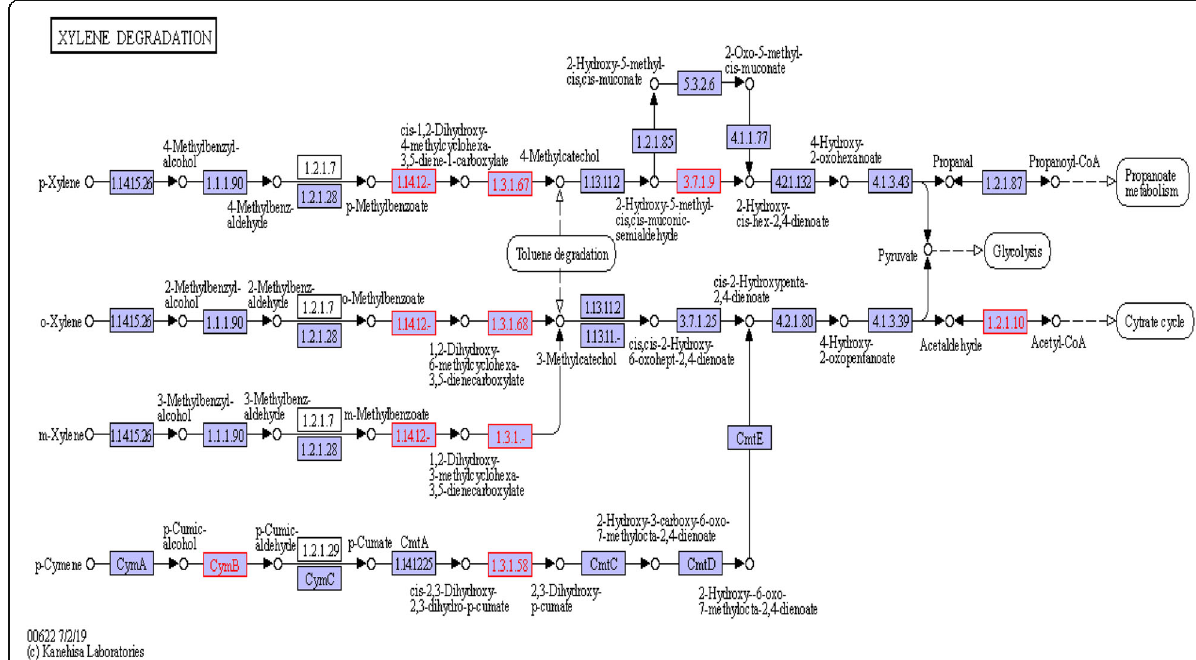
Fig. 5 The xylene degradation pathway performed using the KEGG pathway in KEGG Orthology. EC numbers in red are the xylene degradation genes identified in the FN1 microcosm. The identified genes are mhpF ; acetaldehyde dehydrogenase [EC:1.2.1.10], benD-xylL ; dihydroxycyclohexadiene carboxylate dehydrogenase [EC:1.3.1.25 1.3.1.-], benC-xylZ ; benzoate/toluate 1,2-dioxygenase reductase component [EC:1.18.1.-], dmpD ; 2-hydroxymuconate-semialdehyde hydrolase [EC:3.7.1.9], cymB ; p-cumic alcohol dehydrogenase and cmtB ; 2,3-dihydroxy-2,3- dihydro-p-cumate dehydrogenase